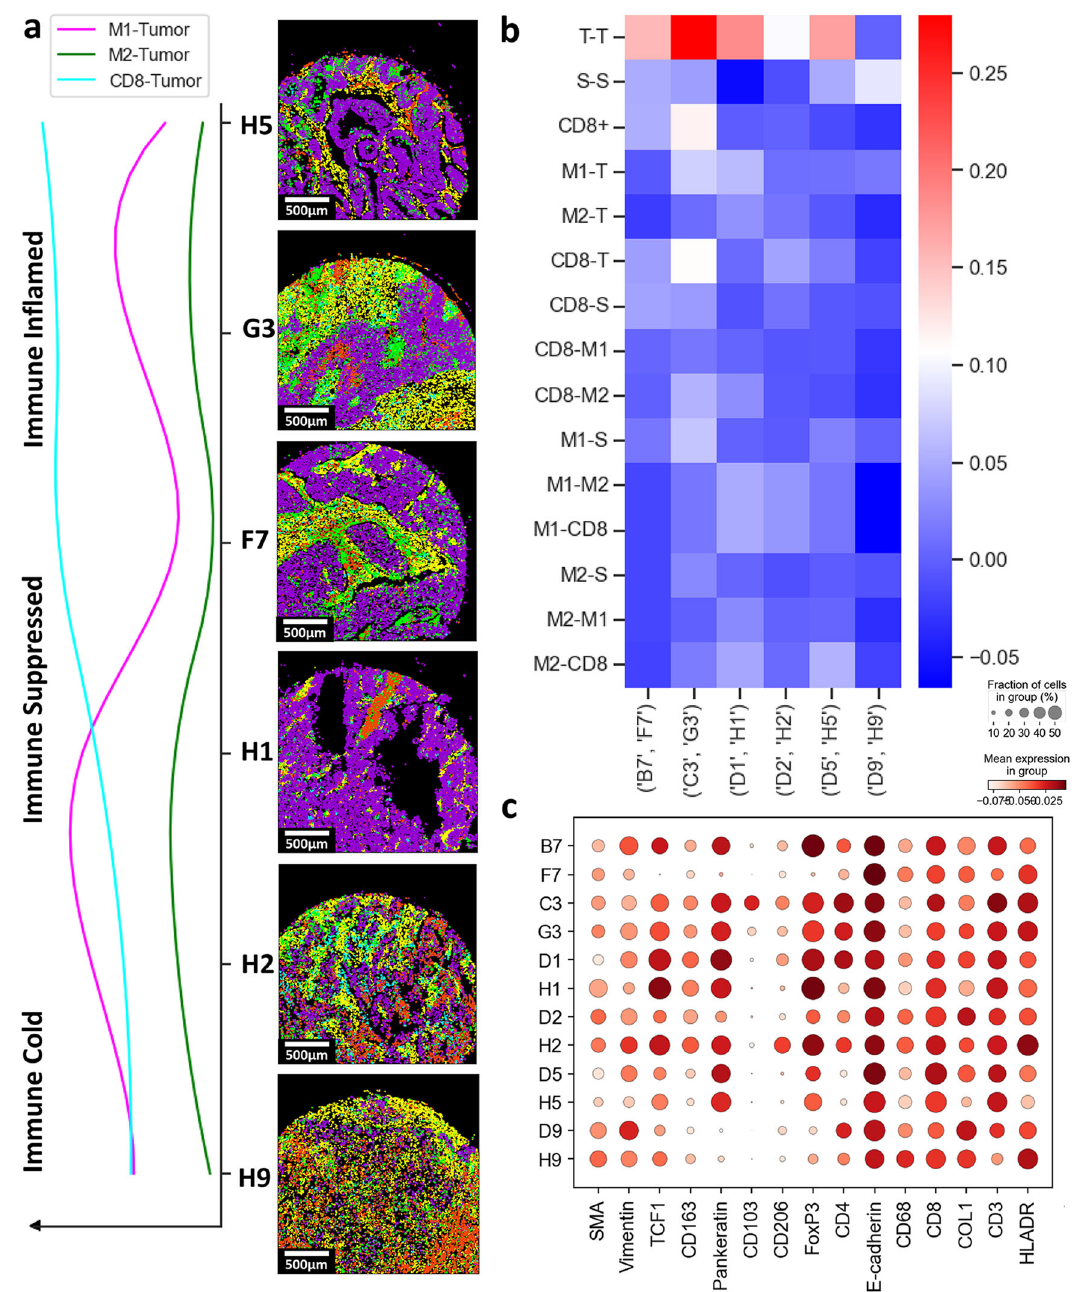
Fig. 6 Correlation of the SpatialVizScores between lung cancer samples and their matched metastatic lymph nodes. a Cell network graphs on patients ’ samples were demonstrated. Magenta represents tumor regions, yellow represents stromal regions, green represents CD8 α cells, red represents M1 cells, and cyan represents M2 cells for the primary tumor and their matched metastatic lymph node samples. A line plot showed the continuum of immune-tumor interactions amongst the immune categoriesgorizes. Tumor-M1 interactions were shown in magenta, Tumor-M2 interactions were show in green, and Tumor-CD8 α interactions were shown in cyan. b Heat map provided the correlation in immunoscores for each matching tissue pair of the primary tumor and matched metastatic lymph node. c Dot plot demonstrated the expression of markers across the primary lung cancer samples and their matched metastatic lymph